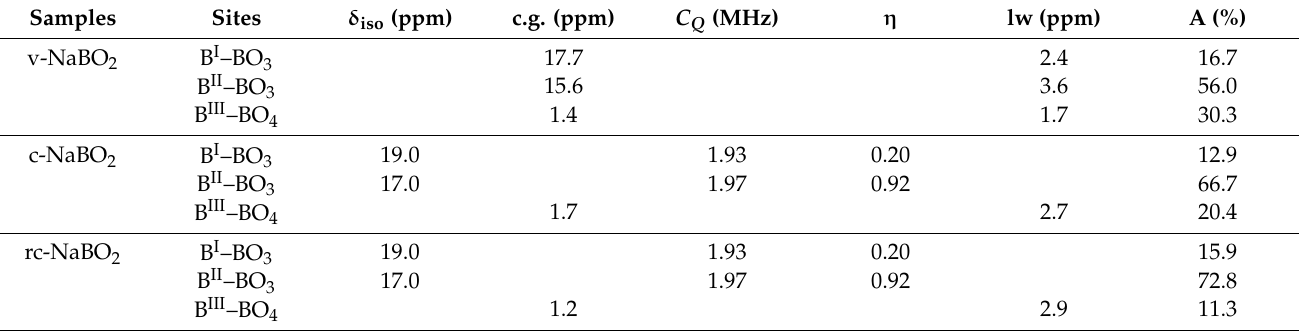
Table 3. Deconvolution of the 11 B spectra at 18.8 T in the three samples of NaBO 2 in Figure